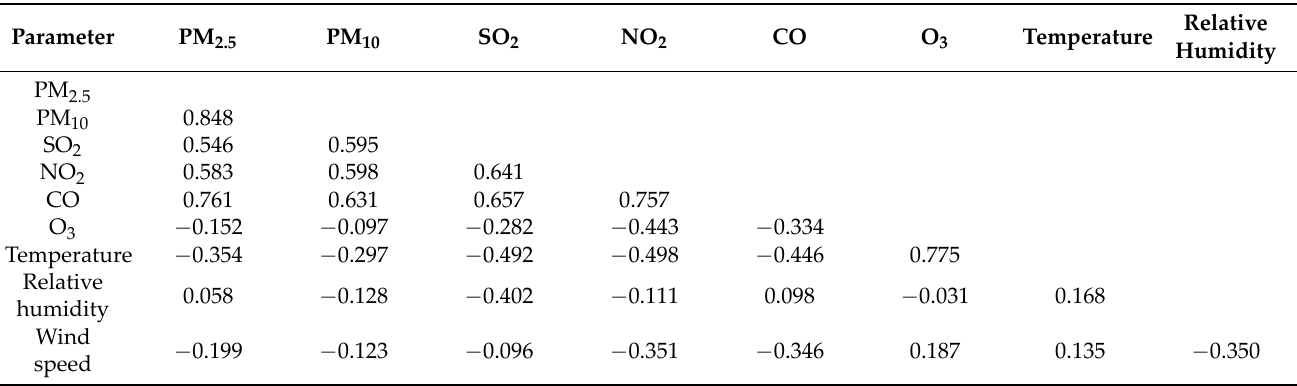
Table 4. Spearman correlation between daily air pollutant concentrations and the meteorological parameters during